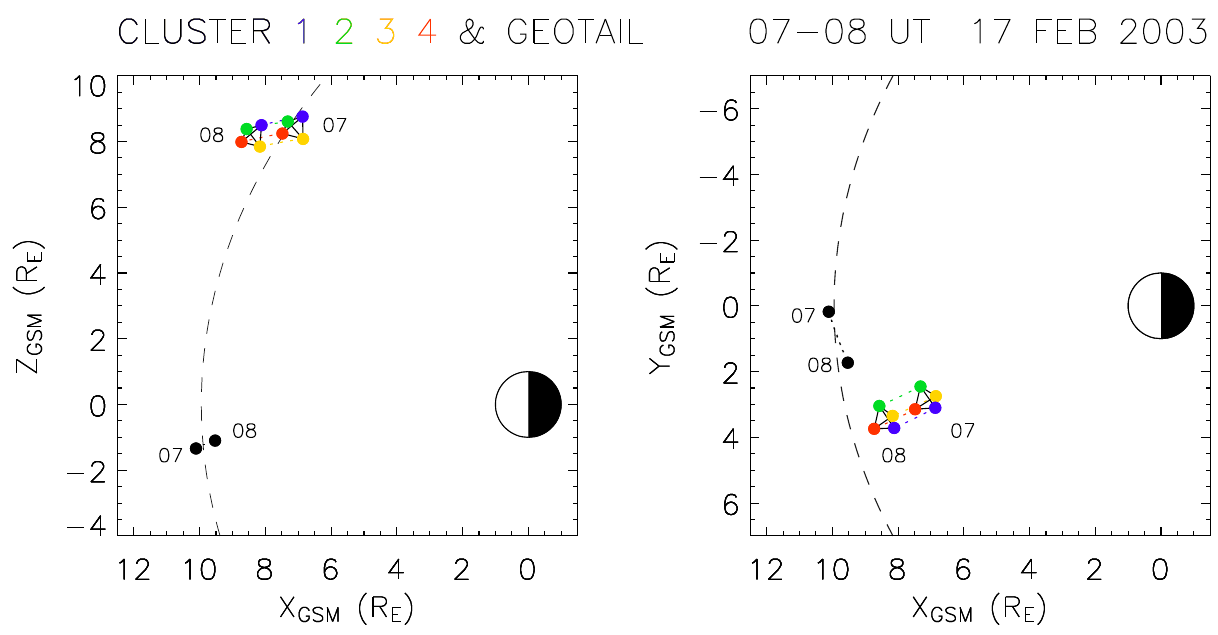
Fig. 1. The orbital motion of the Cluster (coloured circles) and Geotail (black circles) spacecraft presented in the X-Z (left) and X-Y (right) GSM planes during the interval 07:00–08:00 UT on 17 February